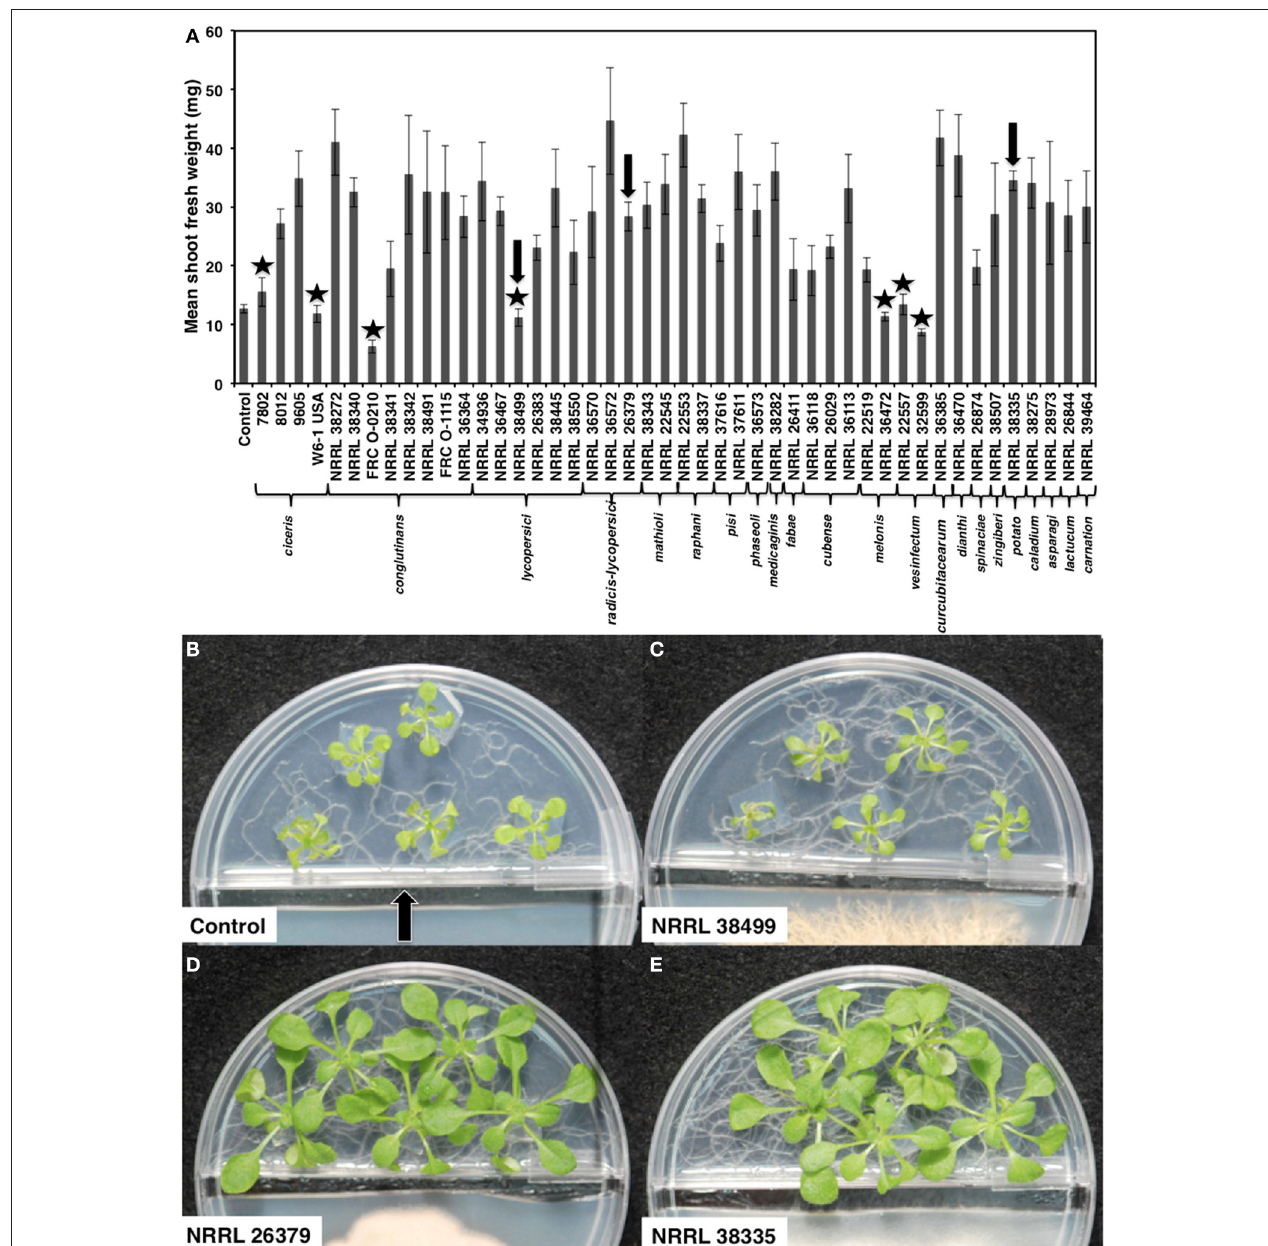
FIGURE 1 | Growth response of A. thaliana to F. oxysporum volatiles. (A) Mean shoot fresh weights of ecotype Col-0 cocultivated with no fungus (control) and 46 F. oxysporum strains individually for 2 weeks are shown. Means and standard errors for nine biological replicates per treatment, with five seedlings per replicate, are shown. Isolates that did not cause statistically significant growth enhancement compared to control (Tukey’s test, α < 0.05) are marked with star. Arrows denote the three strains used for subsequent analyses. Images of seedlings after cocultivation with these three strains are shown in (B–E) . The center partition, marked by an arrow in (B) prevents physical contact between two compartments. A strip of fungal culture medium along the center partition was removed at the time of fungal inoculation to prevent fungal overgrowth to the plant side.